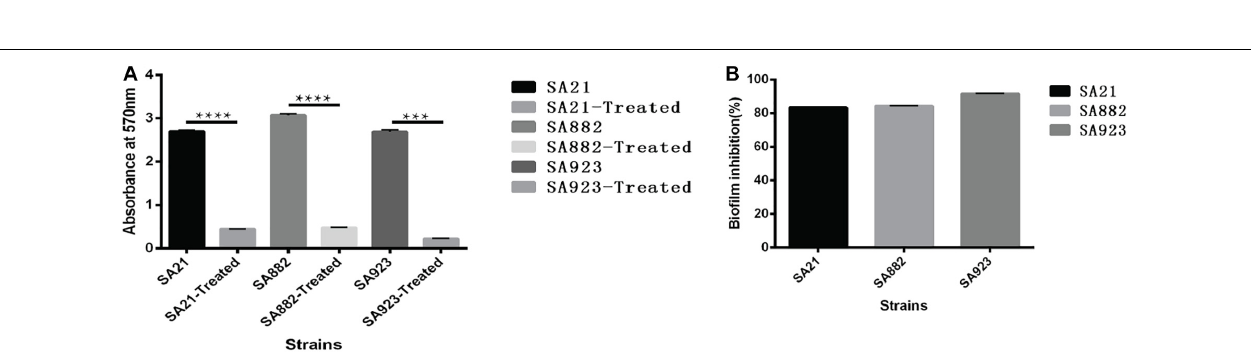
FIGURE 3 | Effect of subinhibitory ZY-214-4 concentration (4 µ g/ml) on S. aureus biofilm formation. (A) OD 570 of each strain differed significantly from that of the control group (grown in the absence of ZY-214-4). (B) Biofilm inhibition rate of 3 S. aureus strains. * P < 0.05.